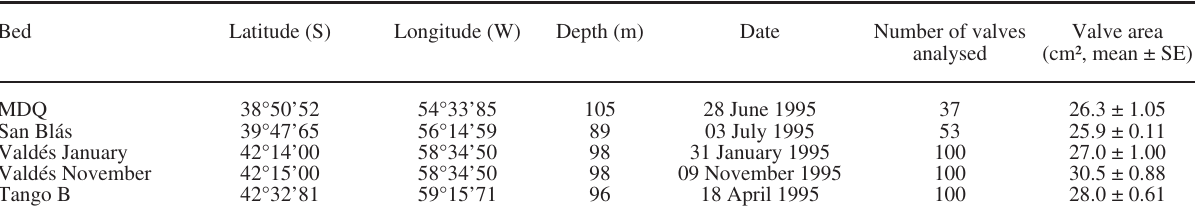
Table 1. – Basic data on the Psychrochlamys patagonica beds sampled by the F/V Erin Bruce , and number and size of the valves analysed in this study. Latitude and longitude in degrees, minutes and cables. Bed Latitude (S)